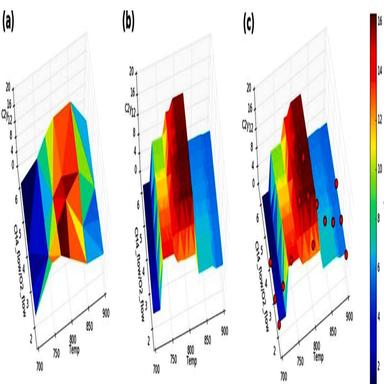
Surface plot of the CH4/O2 ratio and temperature against the C2 yield for Mn–Na2WO4/SiO2. (a) Actual data points, (b) interpolation filling by random forest regressor, and (c) validation with separate experimental data points. Reproduced with permission from American Chemical Society.